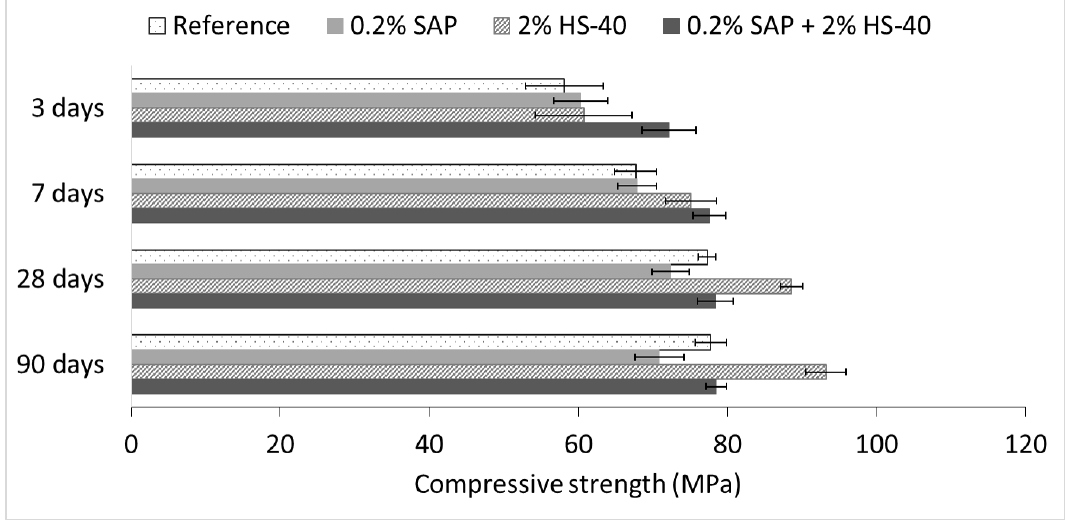
Figure 9. Compressive strength of all series measured at 3, 7, 28 and 90 days.